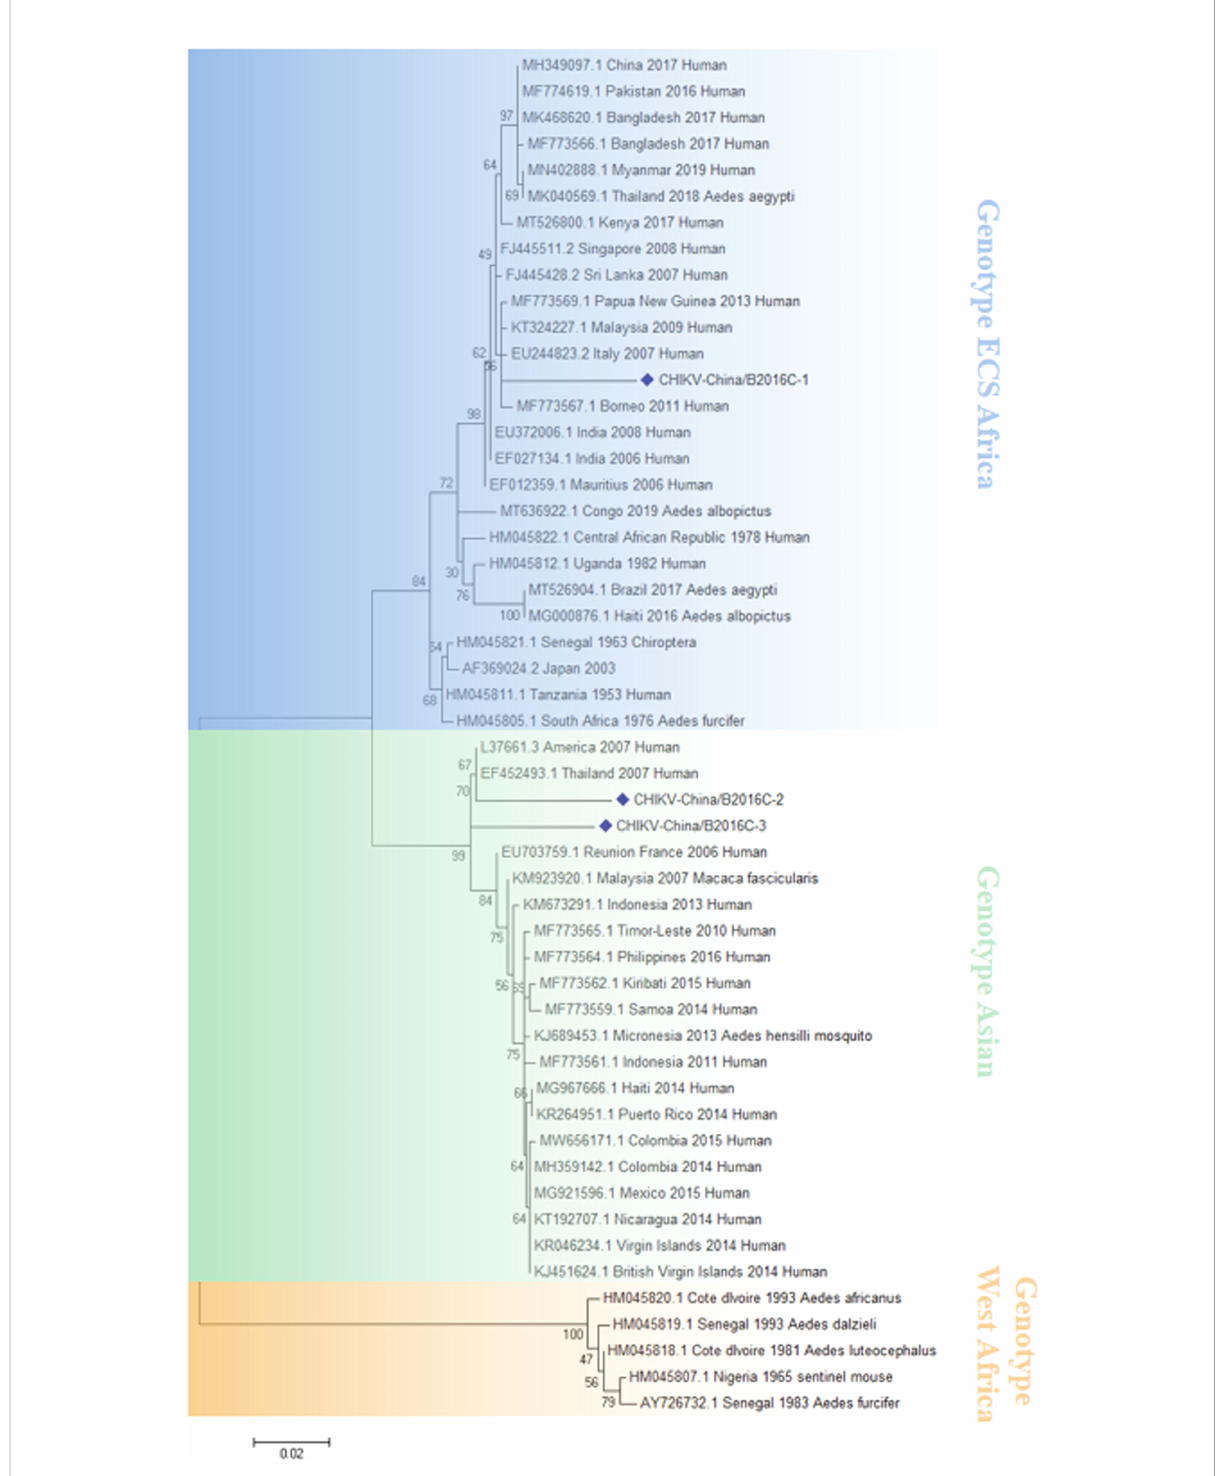
FIGURE 3 The phylogenetic analysis based on CHIKV-C. Complete C gene sequences with 783 nt of CHIKV were used for phylogenetic analysis. The maximum likelihood method was used tree building algorithms in MEGA 7.0, with bootstrap value set to 1,000. Solid blue rhombus was used for marking the viral genes ampli fi ed in the